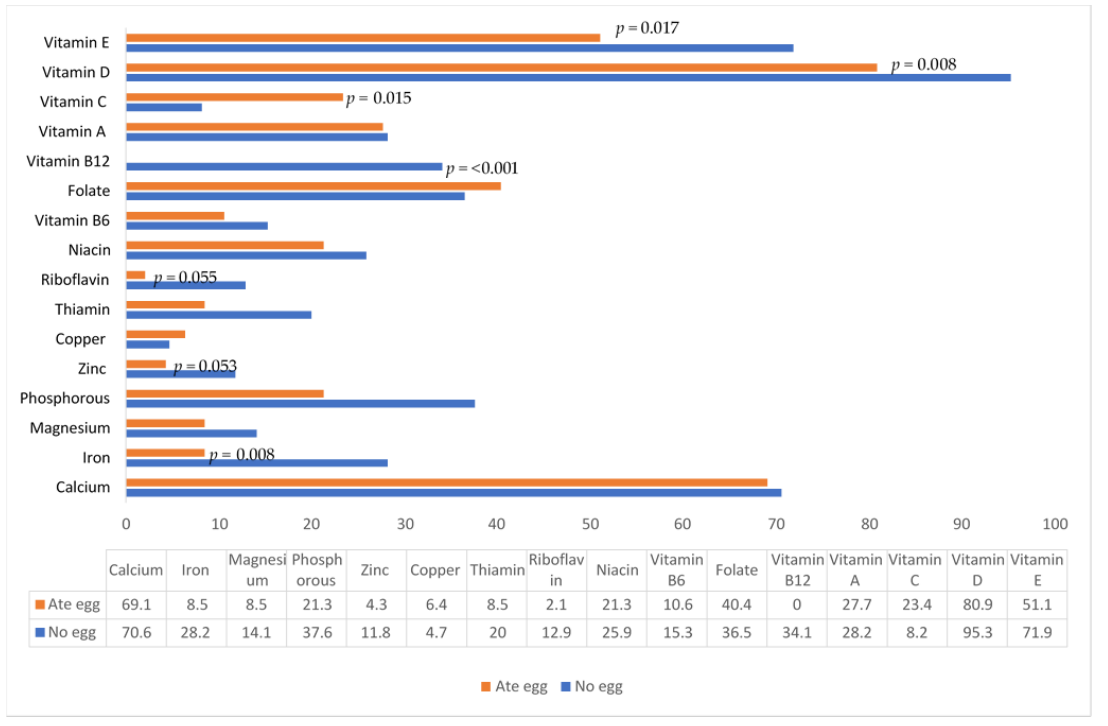
Figure 1. Percentage of babies with intake below the Estimated Average Requirement (EAR) [35,36] for babies who ate egg during the 24-h recall period versus those who did not eat egg, regardless of treatment